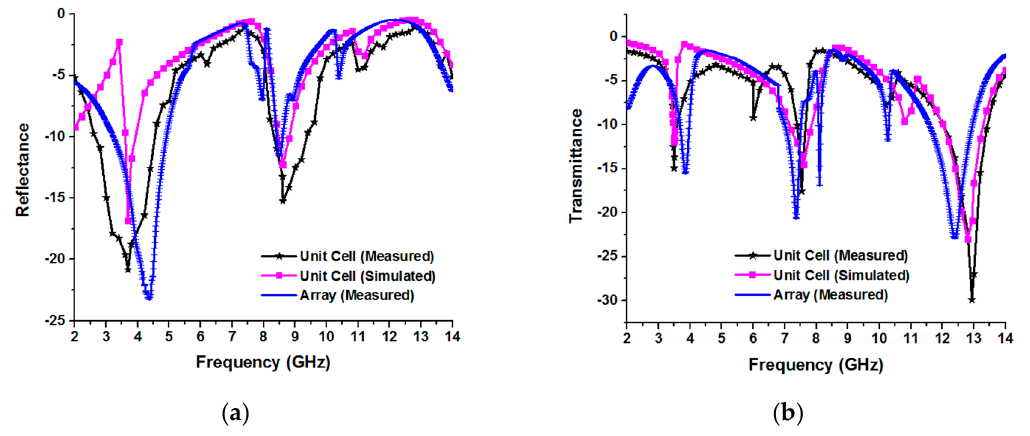
Figure 8. Magnitude (in dB) of: ( a ) the reflection coefficient ( S 11 ) and ( b ) the transmission coefficient ( S 21 ).